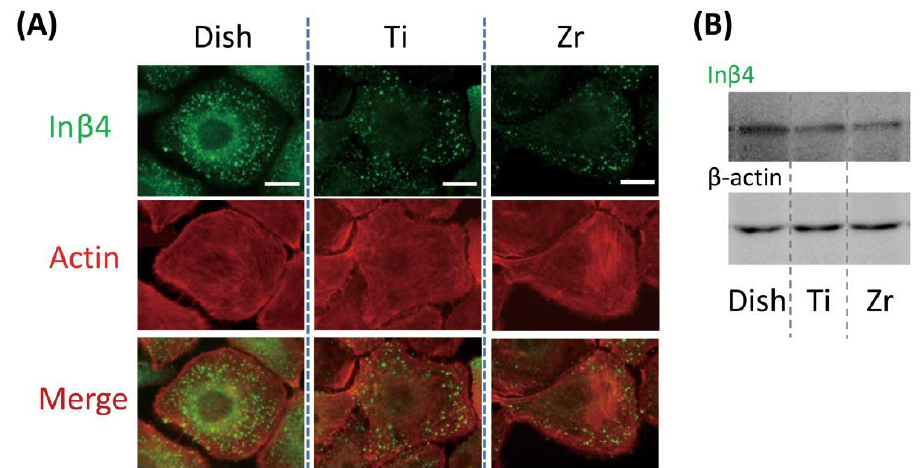
Figure 3. Expression of In β 4 in oral epithelial cells (OECs) on culture dish (Dish), titanium (Ti) and zirconia (Zr) plates. ( A ) Expression of In β 4 subunits and development of actin filaments in OECs in vitro; bar = 15 µ m. ( B ) Western blot analyses of Inβ4.